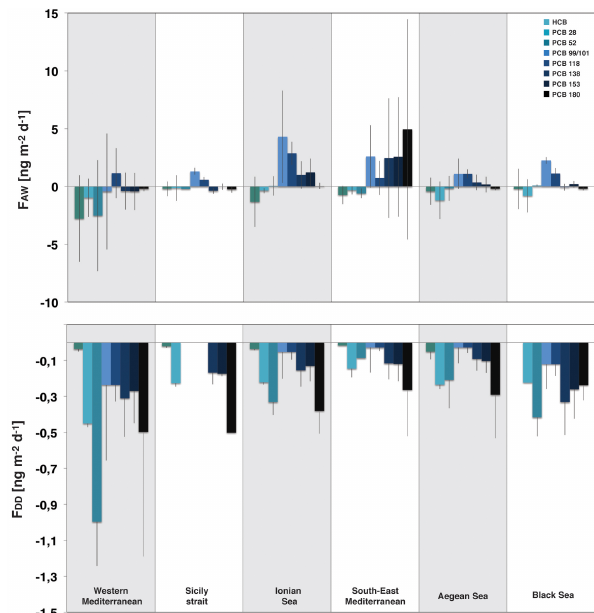
Figure 5. Atmospheric deposition of polycyclic aromatic hydrocar- bons: (lower panel) dry deposition fluxes for the different Mediter- ranean basins; (upper panel) diffusive air–water exchange for the different Mediterranean